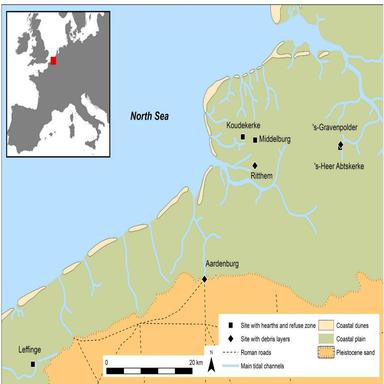
Simplified paleogeographic map of the Belgian coast and Zeeland (NL) in Roman times situating the sites mentioned in the text. (For interpretation of the references to colour in this figure legend, the reader is referred to the Web version of this article.)